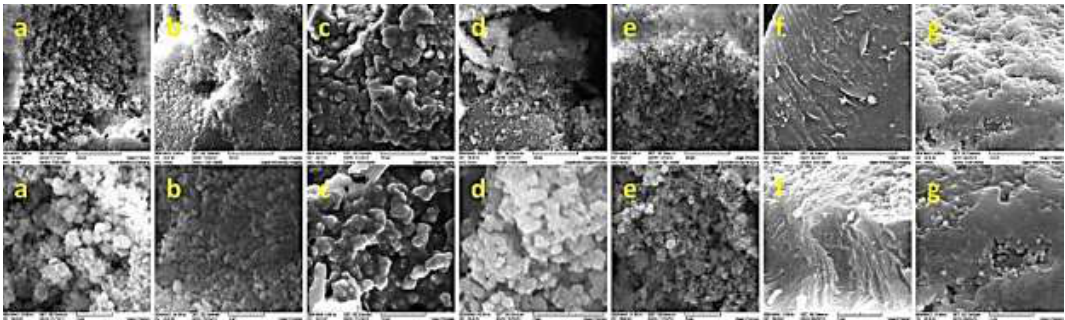
Fig. 4. SEM images of (a) HSNPs-OH, (b) MSNPs-OH, (c) HSNPs-NH